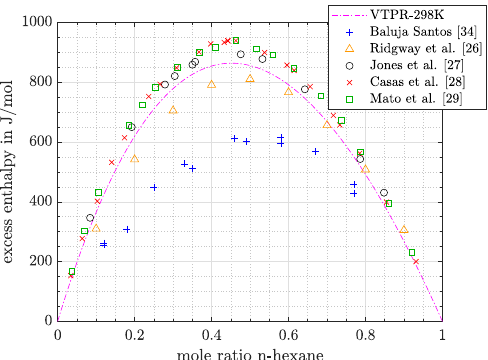
Figure 3. Comparison between experimental data and predicted values of excess enthalpy (system n-hexane/benzene; T = 298.15 K).